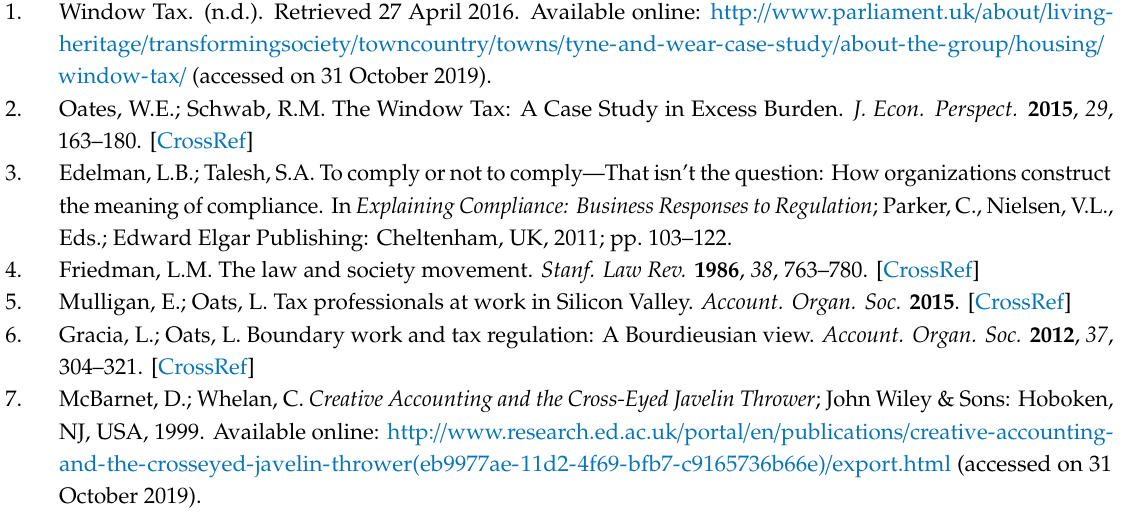
Table S1. Sample characteristics; Table S2. Factor analysis results for tax planning, avoidance and evasion items; Table S3. Variables – descriptive statistics and correlation among study